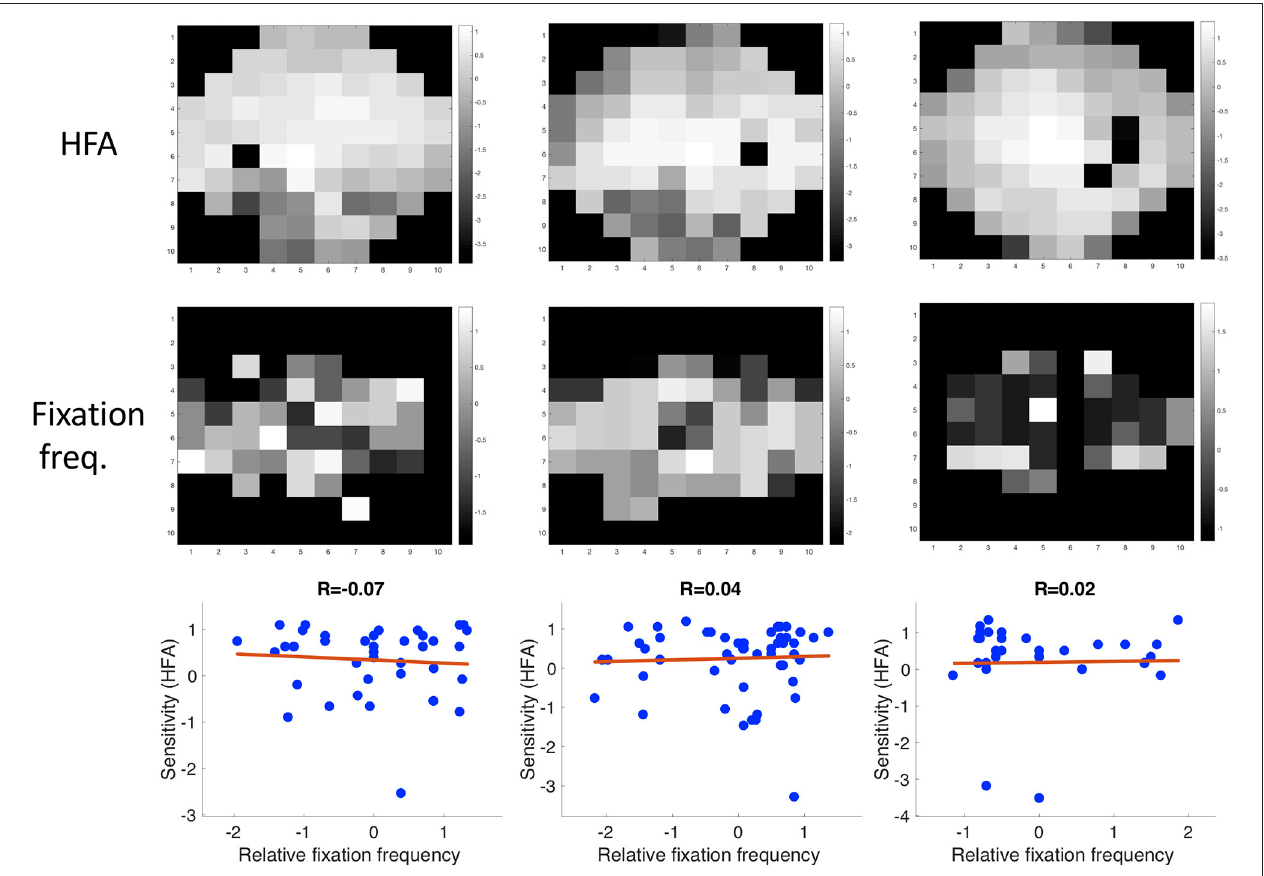
FIGURE 8 | Three examples showing the correlation between sensitivity and the relative frequency of fixating in a discrete region in the visual